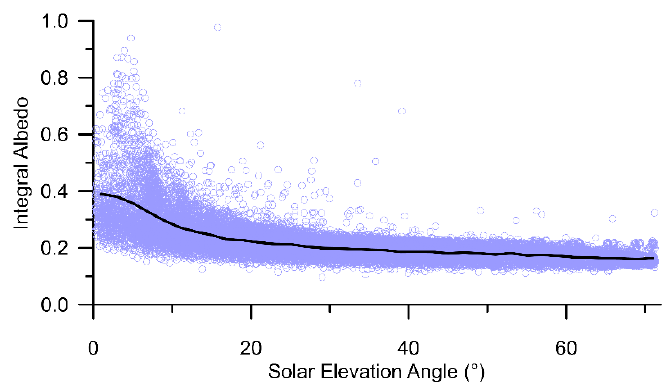
Figure 4. Integral Albedo for CDGr.